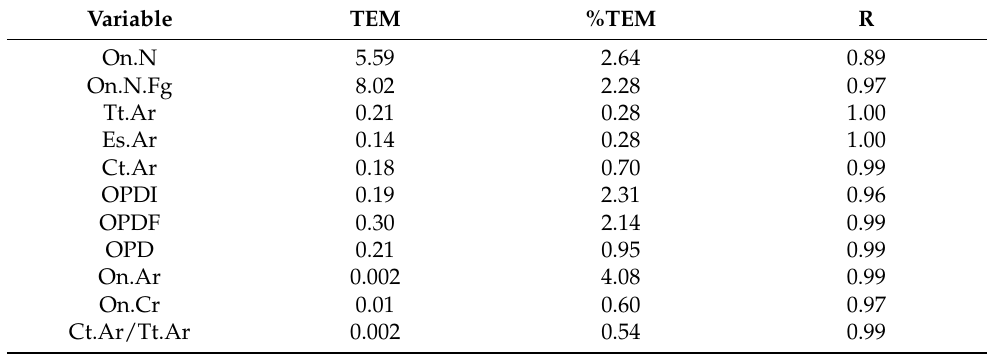
Table 3. Estimation of intra-observer error through the TEM